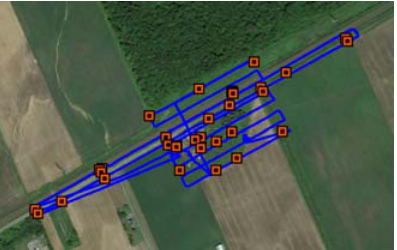
Figure 3: GCP distribution for the block and railway corridor viewed in Google Maps